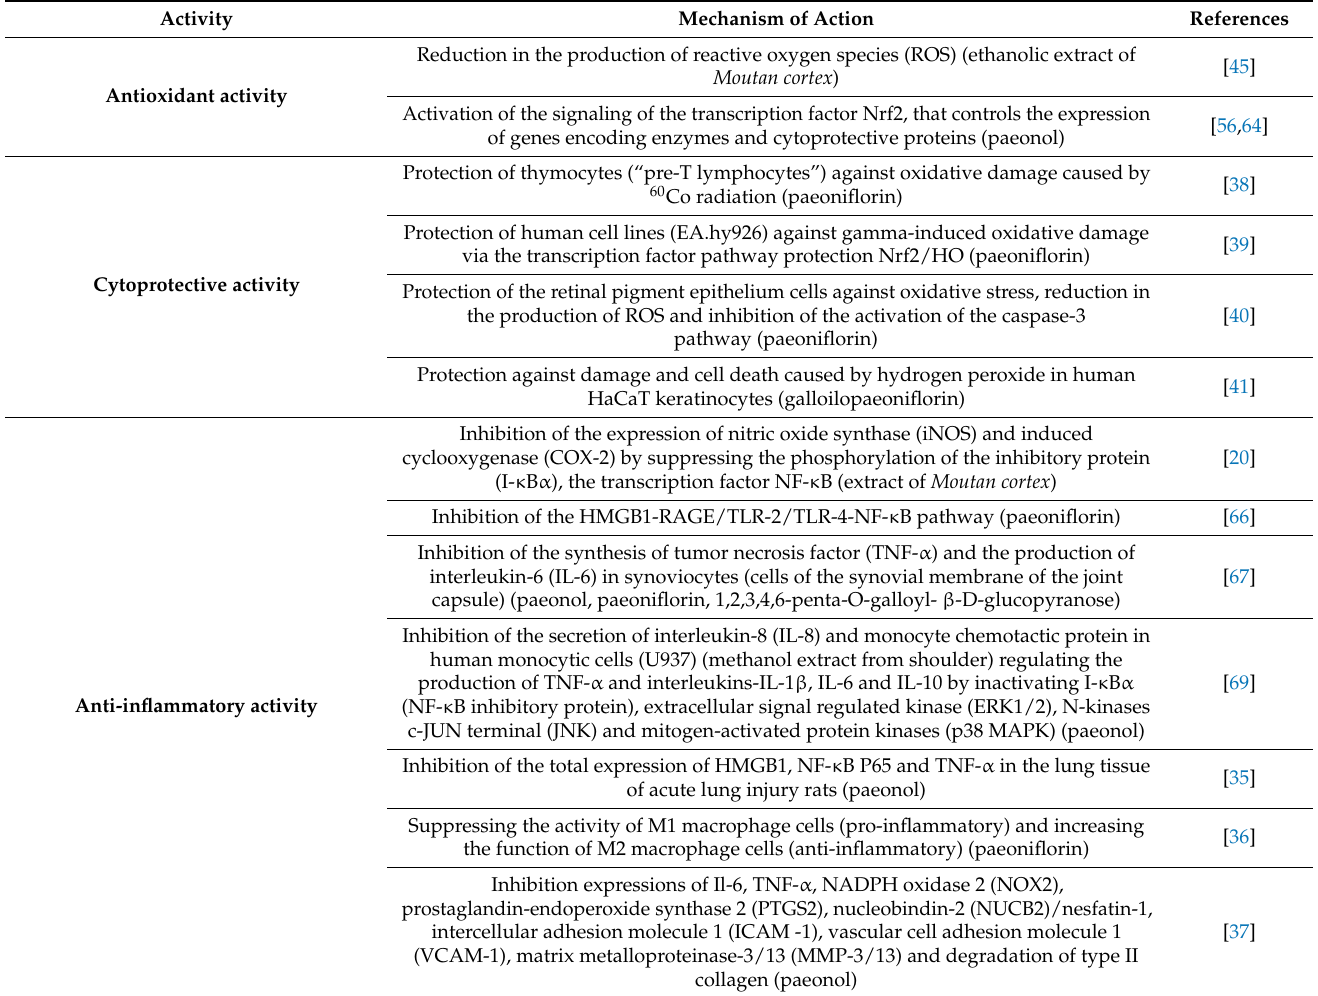
Table 3. Directions and general mechanisms confirmed by scientific research of biological activity of Paeonia × suffruticosa